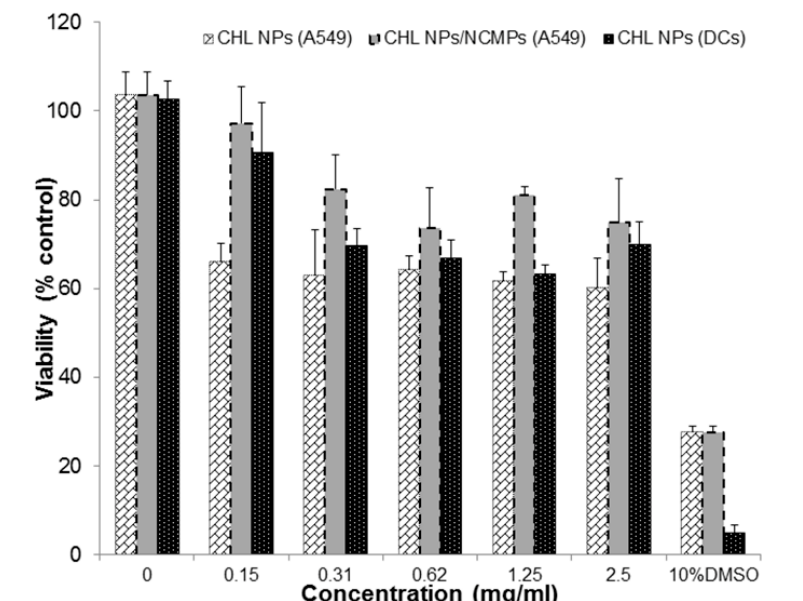
Figure 6. MTT assay to determine cell viability of A549 cells after 24 h of exposure to hybrid cationic CHL NPs and cationic CHL NPs/NCMPs, and DCs after 4 h of exposure to hybrid cationic CHL NPs ( n = 3).